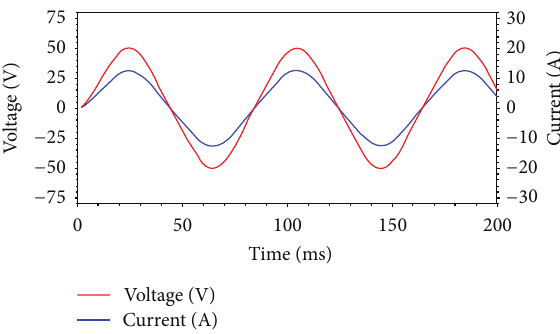
Figure 11: Load voltage and current waveforms.